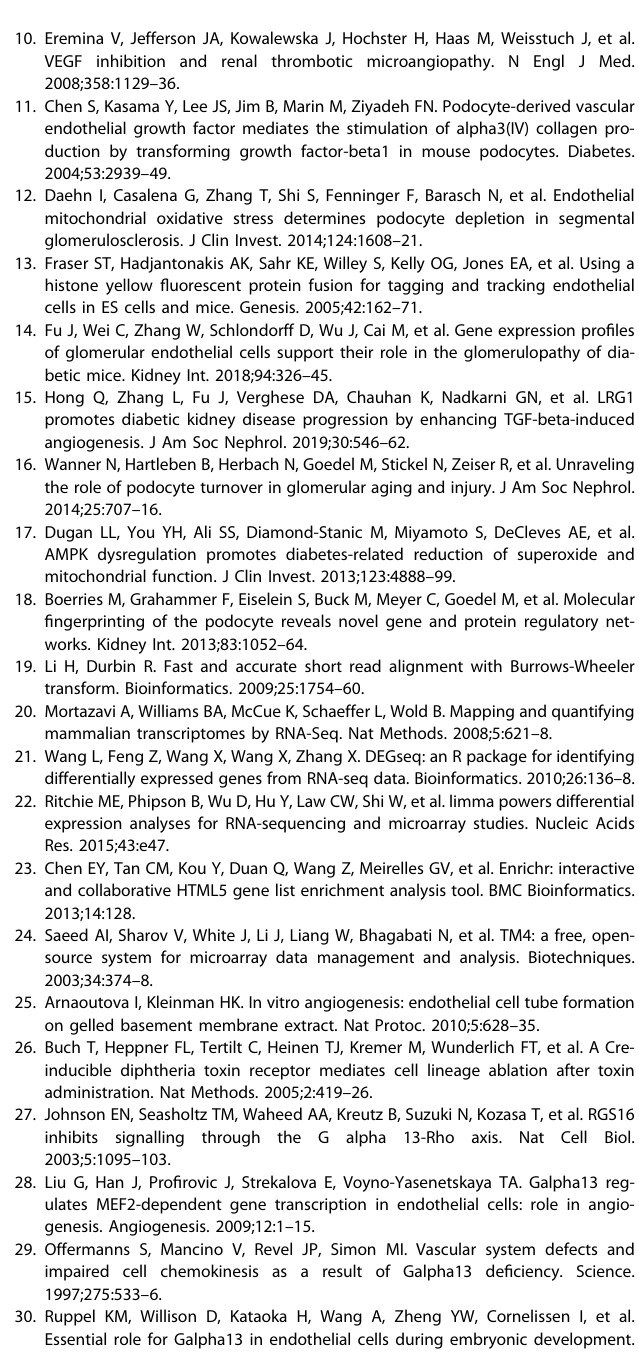
Fig. 7 Activation z- scores and P -values of the top predicted upstream regulators from pathway analysis of DEGs. The blue column shows the z -score and red square shows the − log10 of overlap p -value for individual upstream